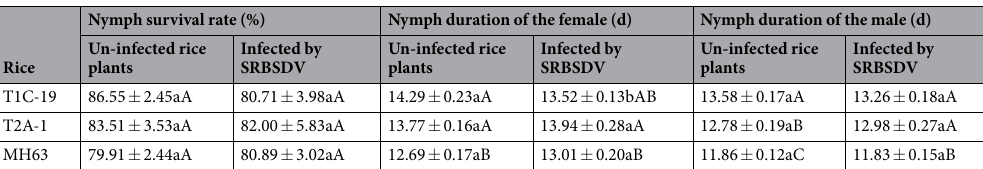
Table 3. Effects of SRBSDV-infected Bt rice on the nymph survival rate and duration of BPH. Note: Data in the table are mean ± SE. The different small letter followed the data in the same row and capital letters followed in the same column indicate significant difference at P < 0.05, respectively, by Turkey’s multiple